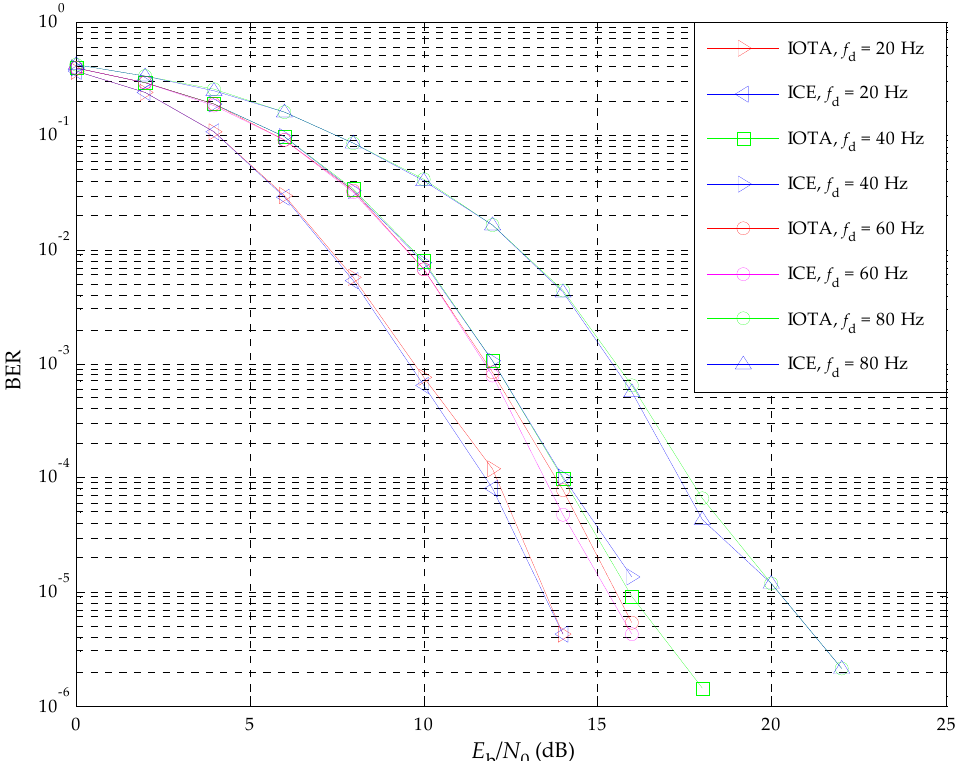
Figure 8. BER performance of the OFDM/OQAM system over Rayleigh fading channels with Doppler spread of 20, 40, 60, and 80 Hz.